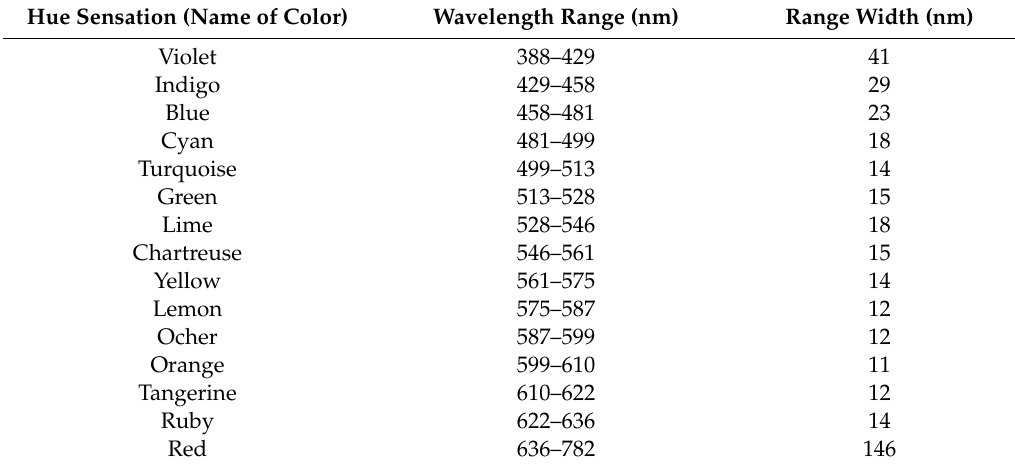
Table 2. Hue sensation and corresponding wavelength range. Data extracted from [61].